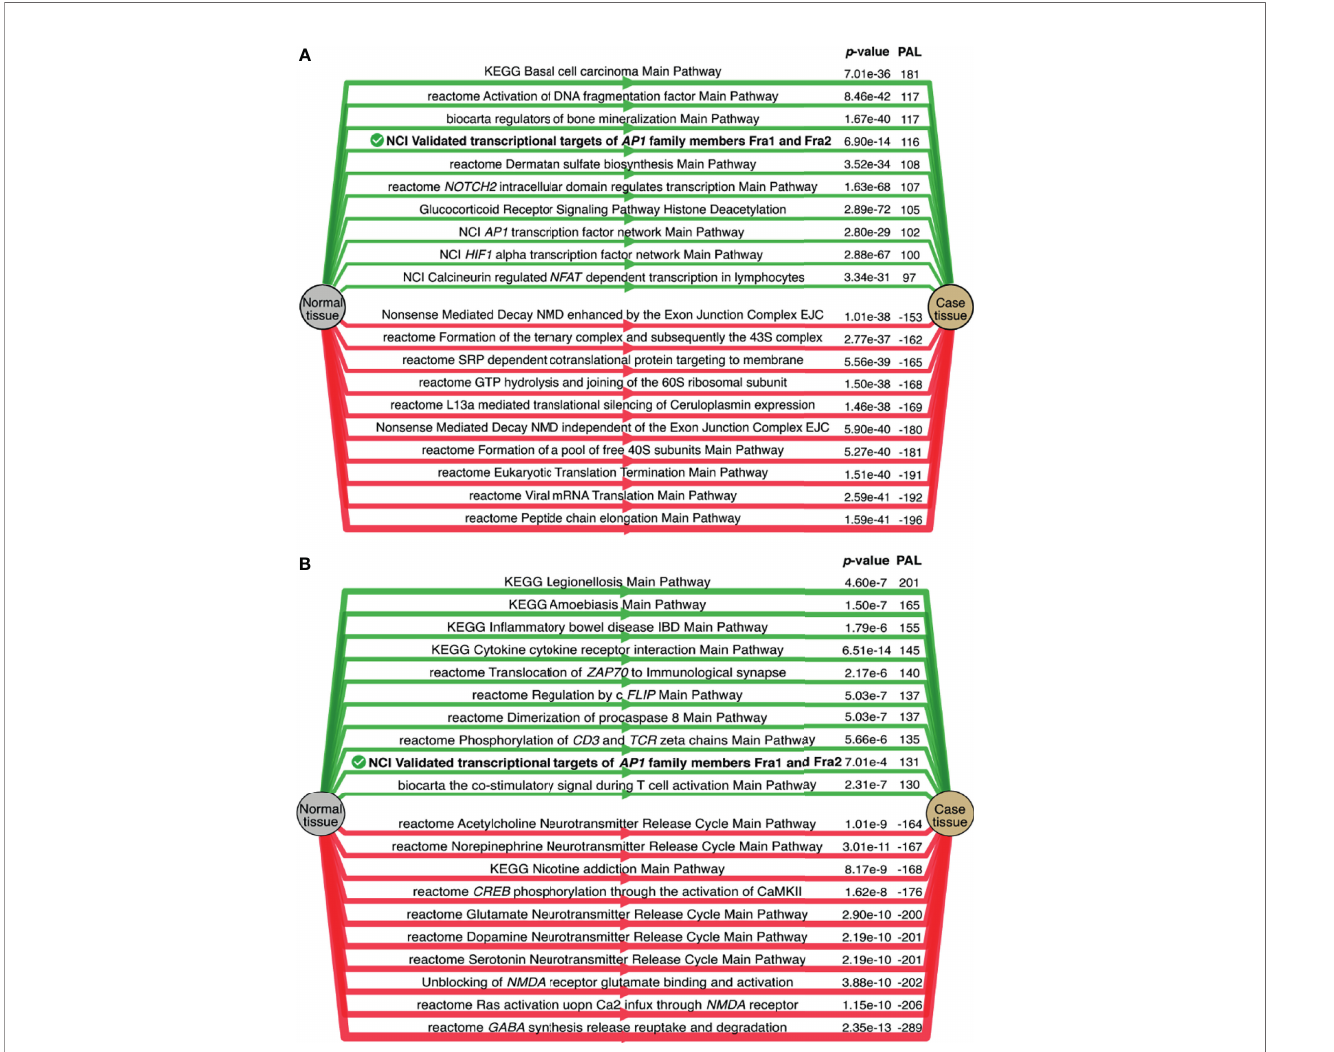
FIGURE 6 | Top 10 activated (green) and suppressed (red) molecular pathways for the comparisons of spinal intramedullary astrocytomas (SIAs) with (A) GTEx healthy spinal cord and (B) ANTE normal brain samples. Common top differential pathways are shown in